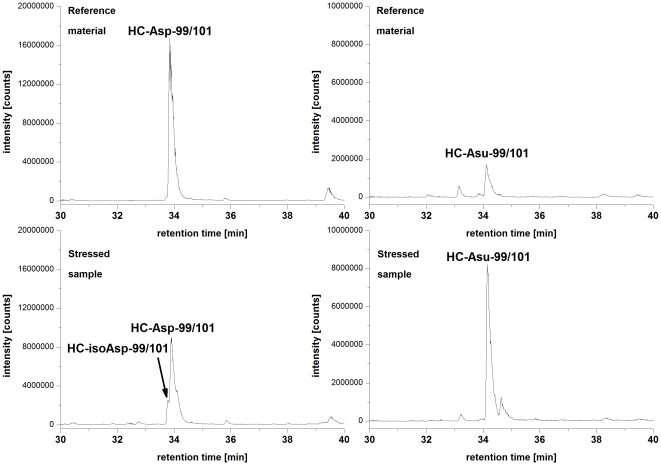
Specific ion chromatograms (SICs) of Mab1 peptides containing LC-Asx-99/101.M = 5464.46 Da (z = 3, 4, and 5) (HC-Asp-99/101; HC-iso-Asp-99/101) and M = 5446.45 Da (z = 3, 4, and 5) (HC-Asu-99/101) from the Mab1 reference material and a stressed sample (stored at 40°C for 2 month).